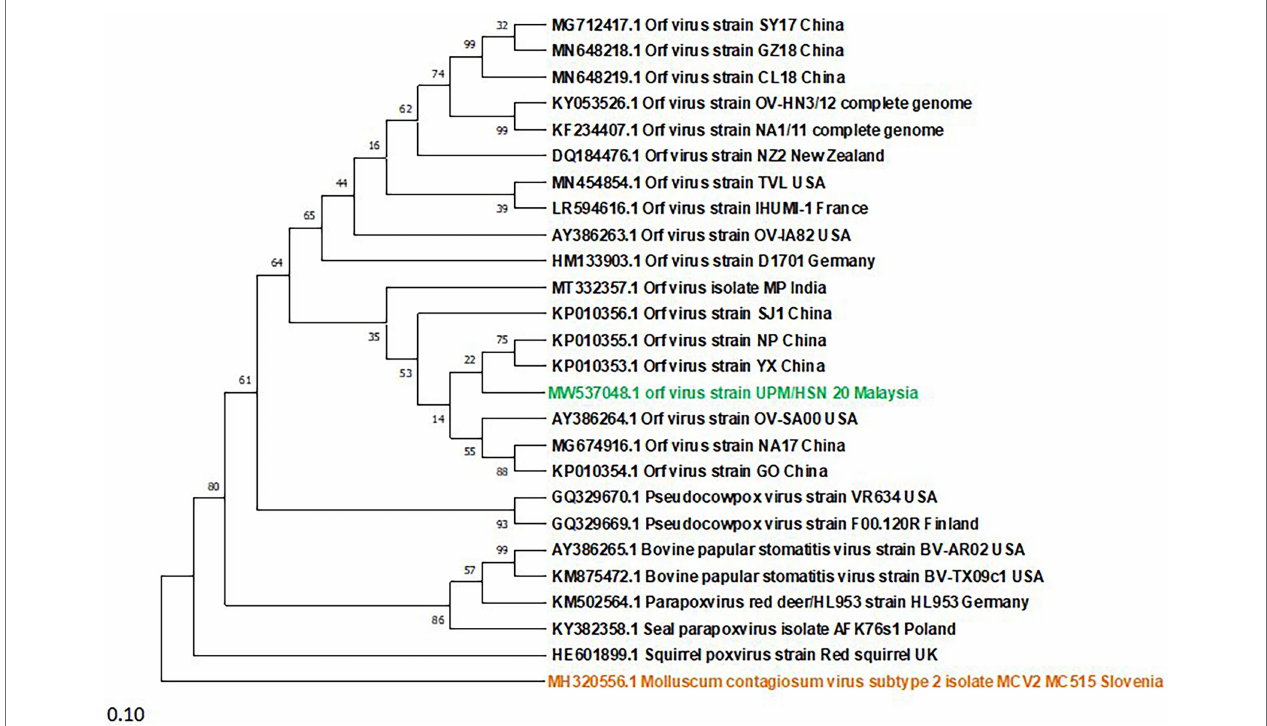
FIGURE 3 | Phylogenetic tree based on highly conserved ORFIII gene of parapoxviruses and other closely related poxviruses. The tree was constructed using the maximum likelihood methods and Tamura-Nei model with 1000 bootstrap replicates in NIEGA-X software.